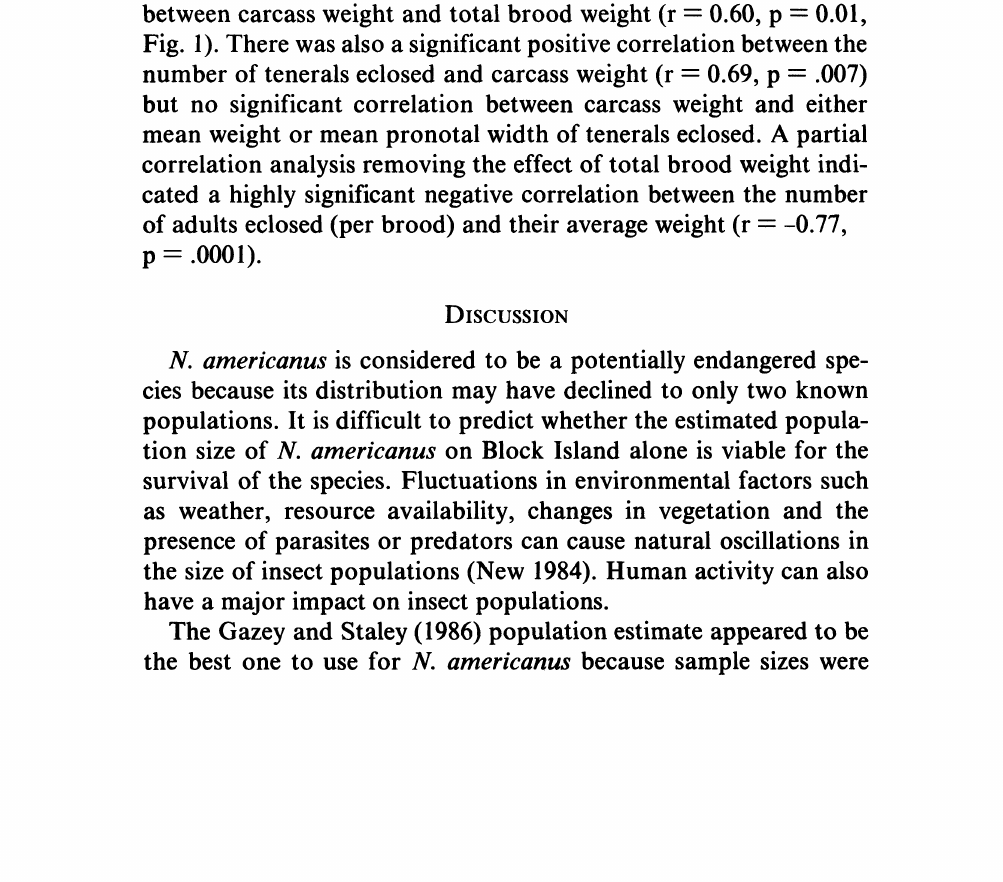
Species abbreviations are same as those for Table 1. N sample